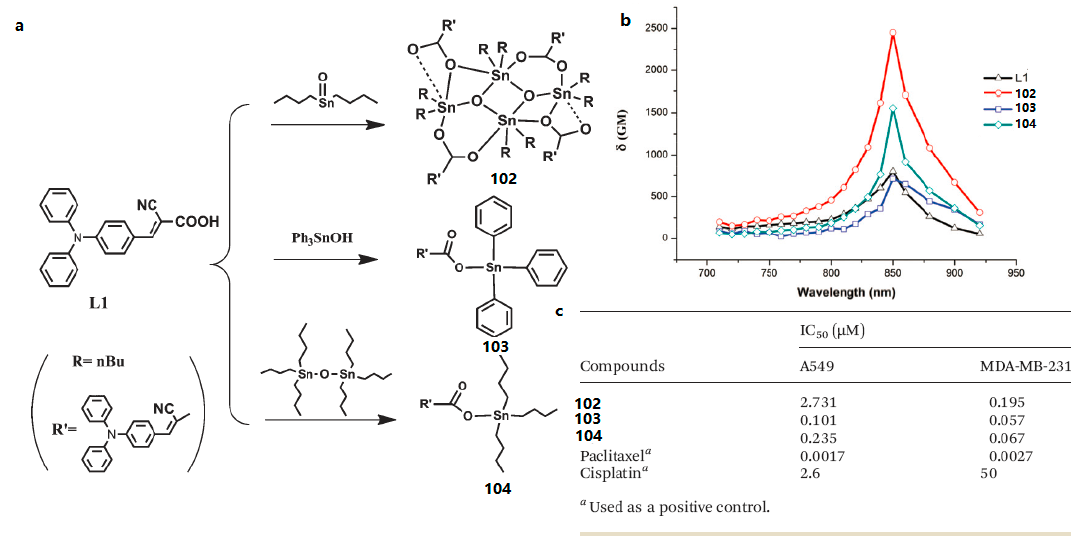
Figure 29. ( a ) Synthetic routes for L1 and complexes 102 , 103 , 104 ; ( b ) 2PA cross-sections of L1 and complexes 102 – 104 in CH 2 Cl 2 solution; ( c ) Inhibitory concentration IC 50 ( μ M) of 102 – 104 against tumor cell lines.